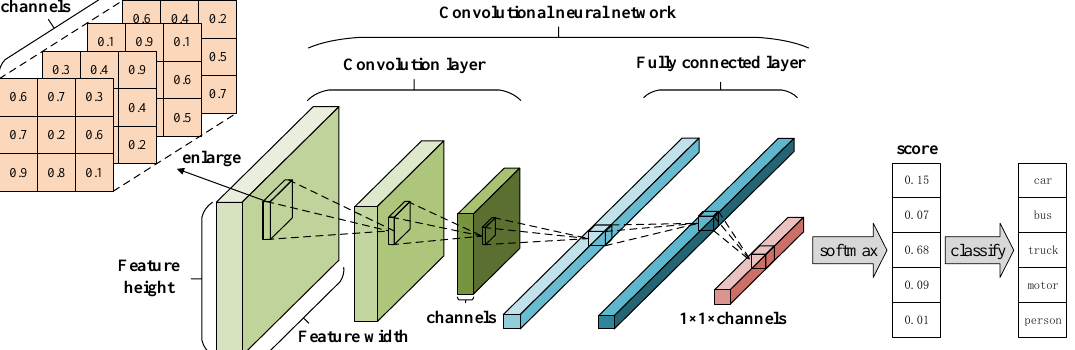
Figure 1. Architecture of a Convolutional Neural Network (CNN). The traditional CNN structure is mainly composed of convolution layers, pooling layers, fully connected layers, and some activation functions. Each convolution kernel is connected to the part of feature maps. The input is connected to all of the output elements in the fully connected layer.